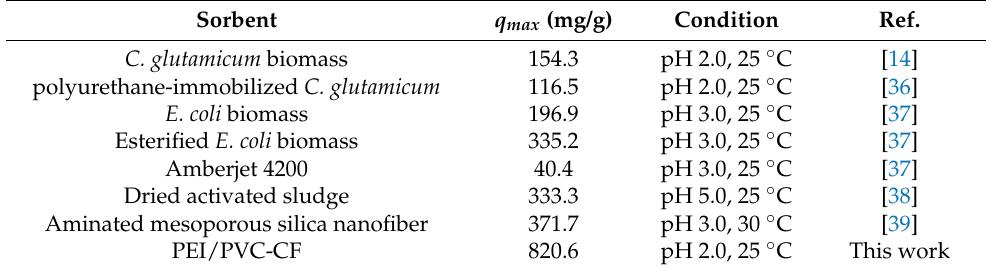
Table 3. Comparison of the maximum adsorption capacity of RY2 on various sorbents.